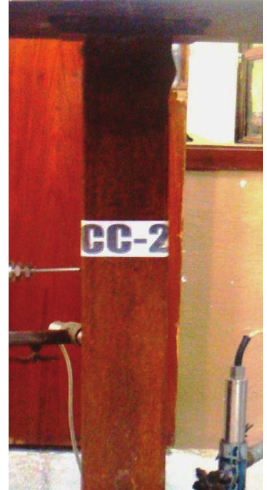
Figure 4: Failure mode of control column.